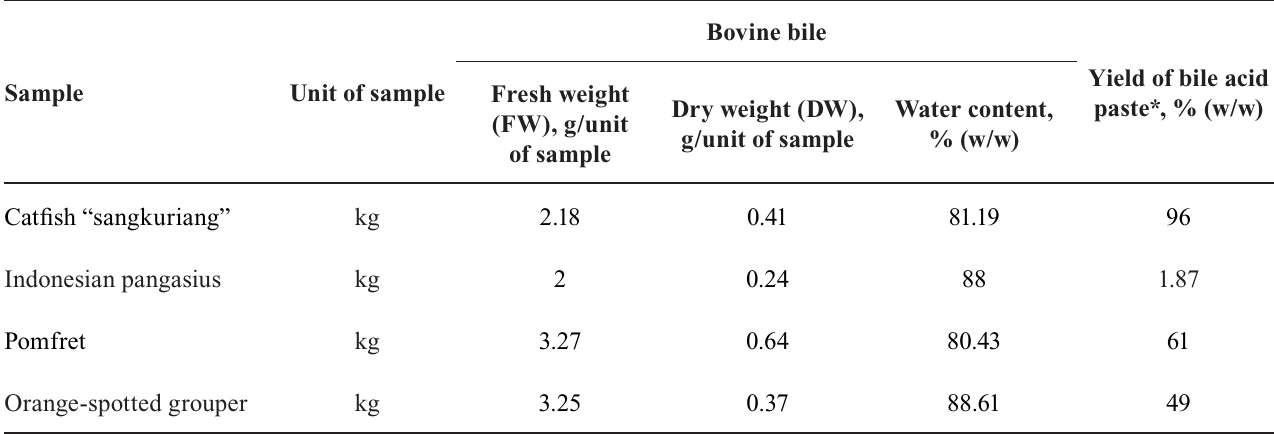
TABLE I - A nimal samples and their biliary bile contents